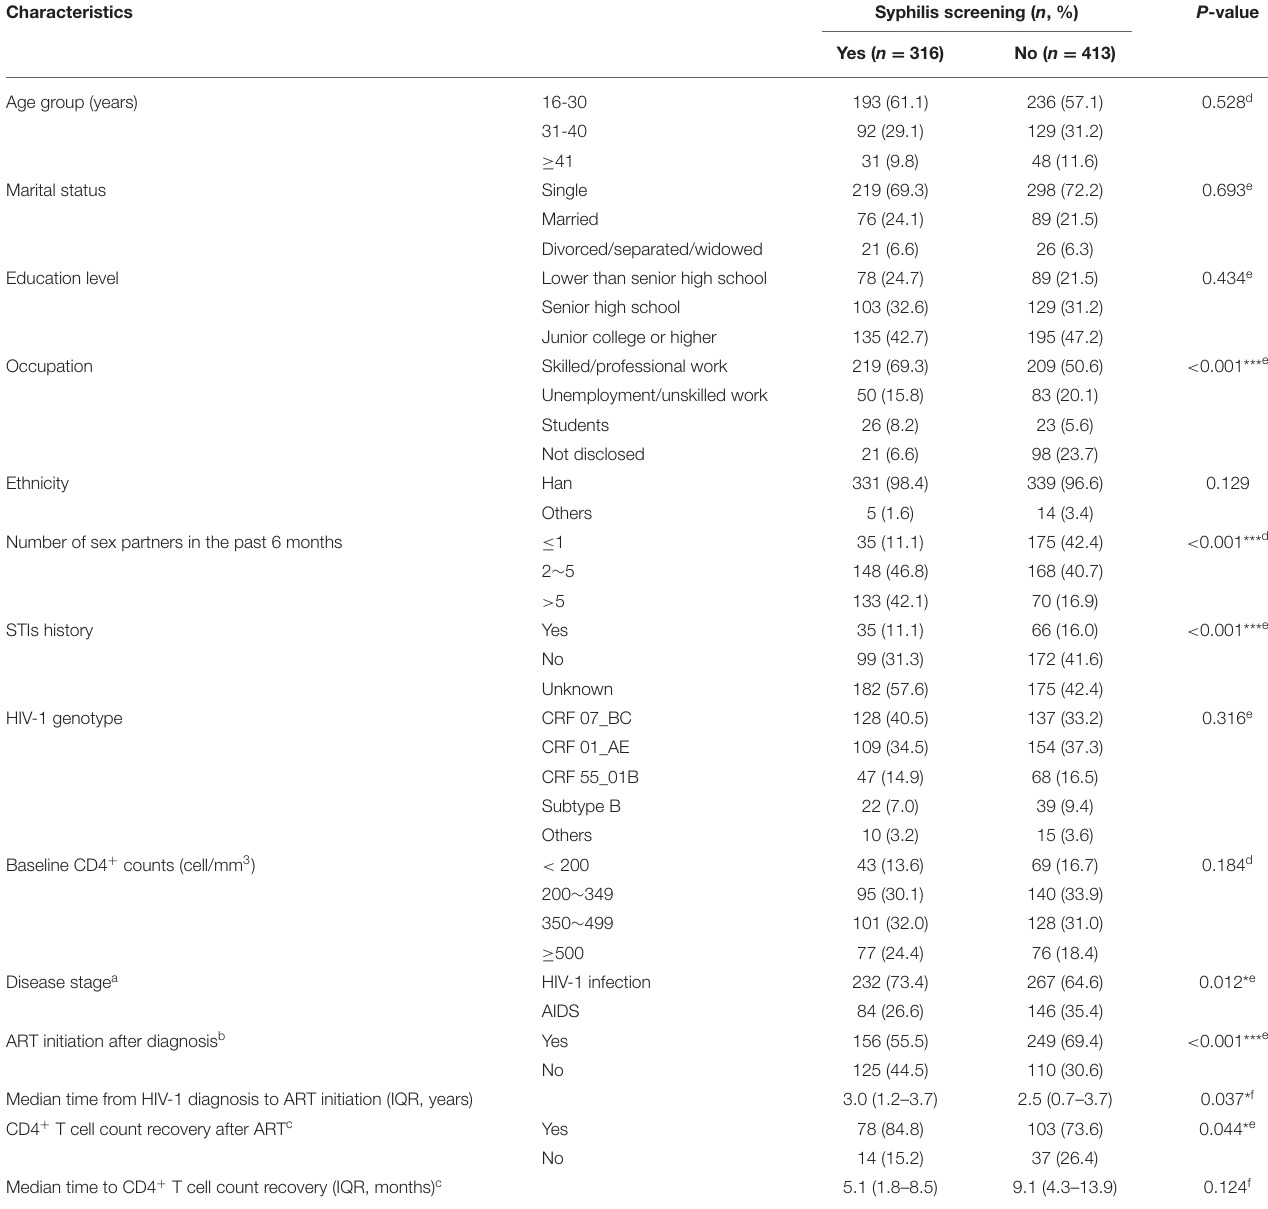
TABLE 3 | Comparison of demographic characteristics for HIV-infected MSM with or without syphilis screening from 2008 to 2012 in Guangzhou, China.